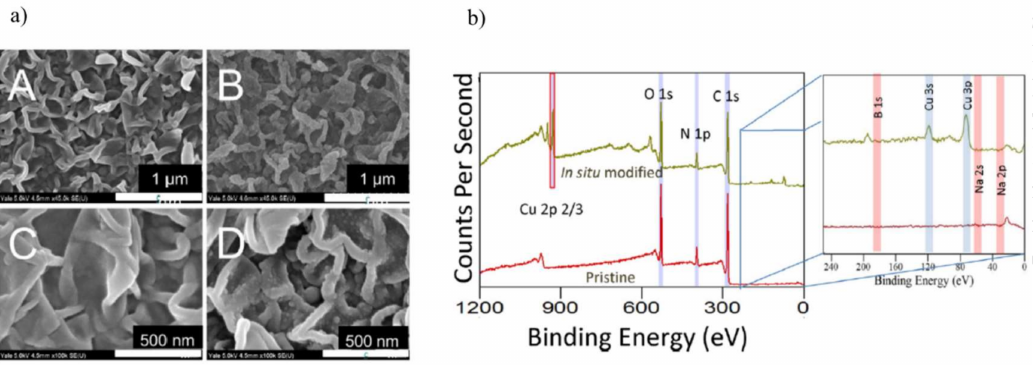
Figure 12. ( a ) SEM images of: ( A , C ) pristine; and ( B , D ) Cu-NPs TFC-RO membrane; and ( b ) XPS spectra of pristine (red) and modified Cu-NPs TFC membrane (green). The copper peaks are at 932 eV. Adapted from Ben-Sasson et al.